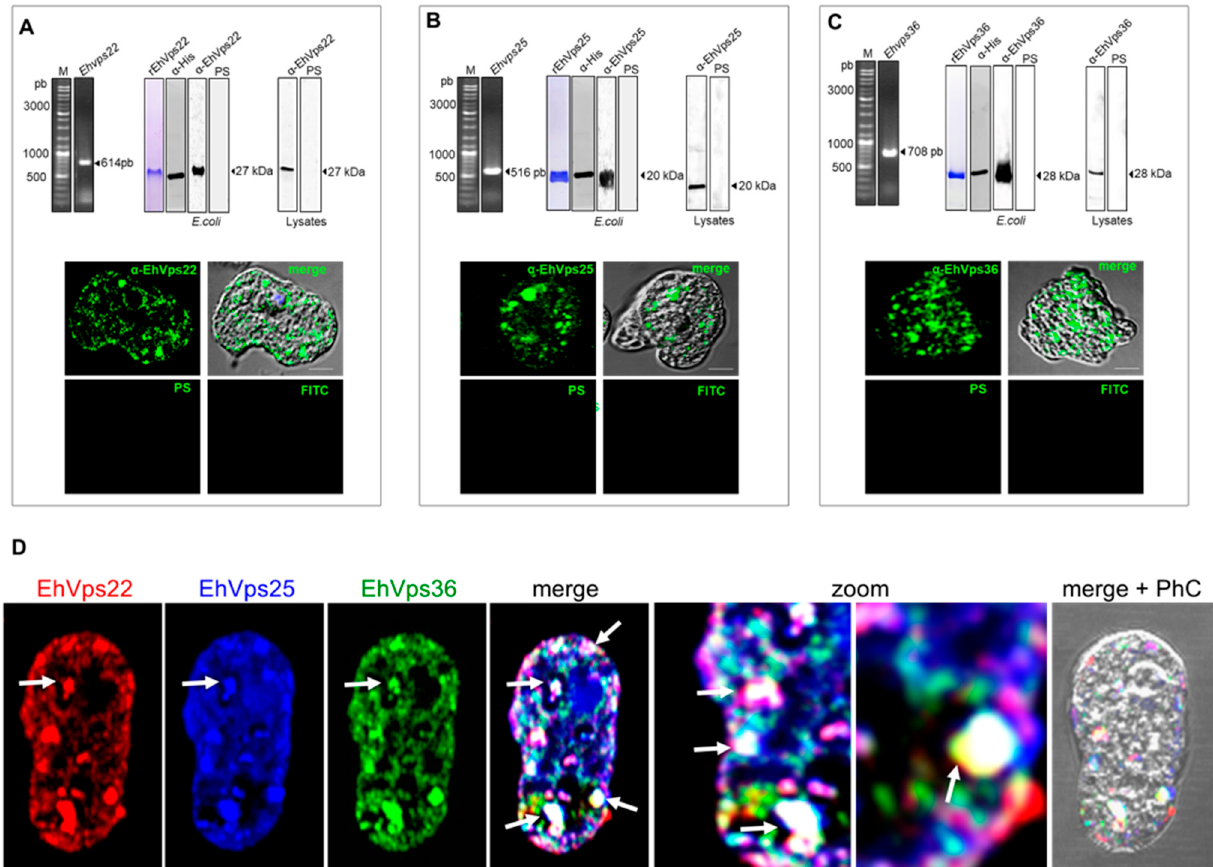
Figure 4. Cellular localization of ESCRT-II proteins in E. histolytica trophozoites. ( A – C ). Cloning, expression, and amplification of the respective genes. ( A ) Detection of EhVps22, ( B ) EhVps25, and ( C ) EhVps36 proteins in bacterial and amoebic lysates. PS: pre-immune serum. The lower images show the cellular localization of EhVps22, EhVps25, and EhVps36 proteins in the trophozoites. Negative controls: PS and secondary antibody (FITC). ( D ) Images of trophozoites under basal conditions showing the co-localization sites of EhVps22 (red), EhVps25 (blue), and EhVps36 (green) proteins. PhC: phase contrast images. Arrows and zoom indicate co-localization sites between proteins. Scale bar = 10 µm.